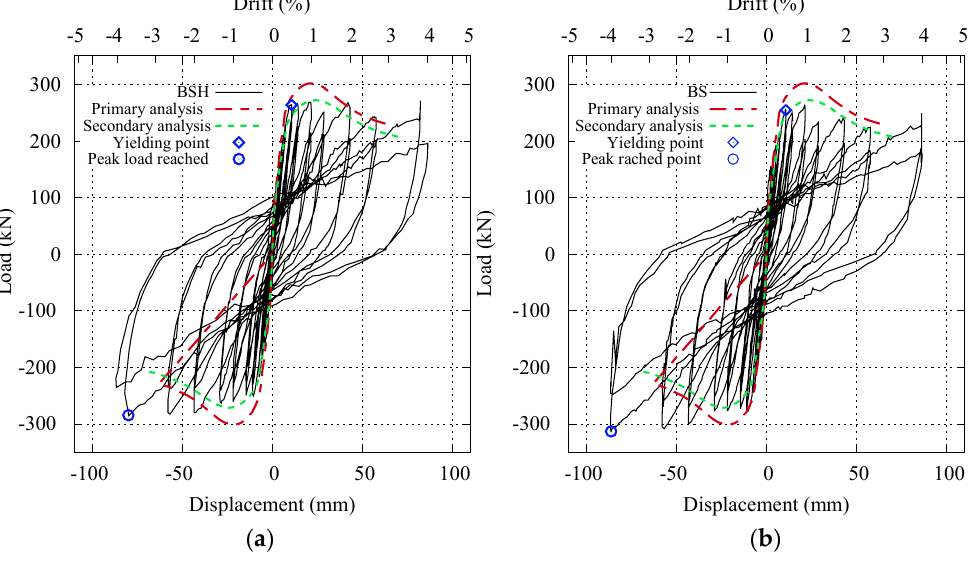
Figure 6. Relationship between horizontal load and lateral displacement: ( a ) BSH; ( b ) BS.